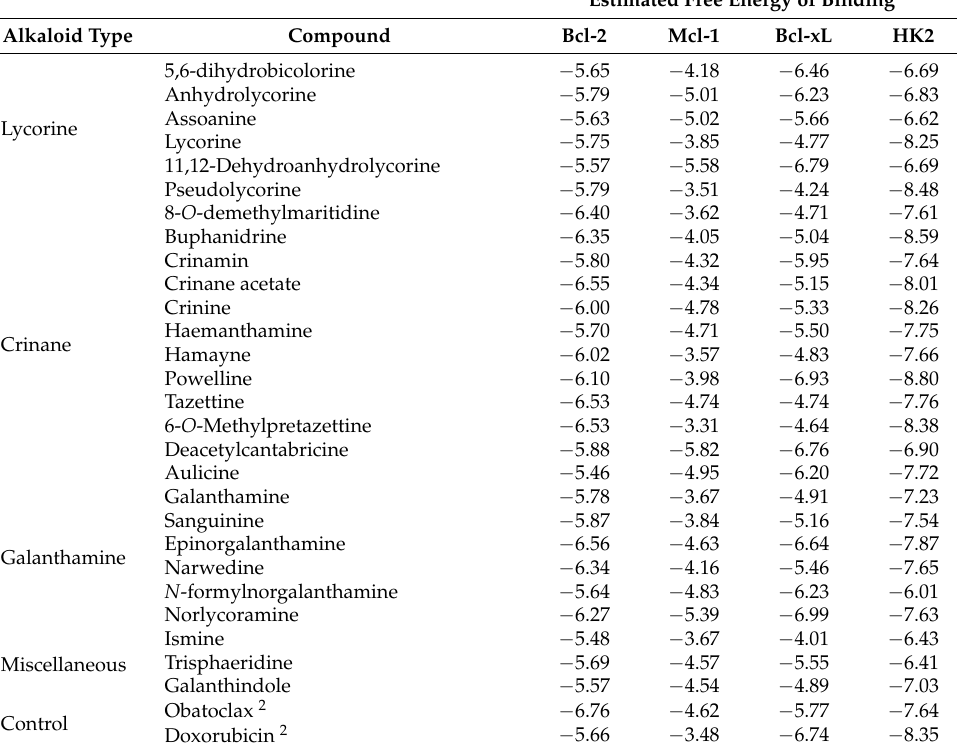
Table 4. Molecular docking analysis.